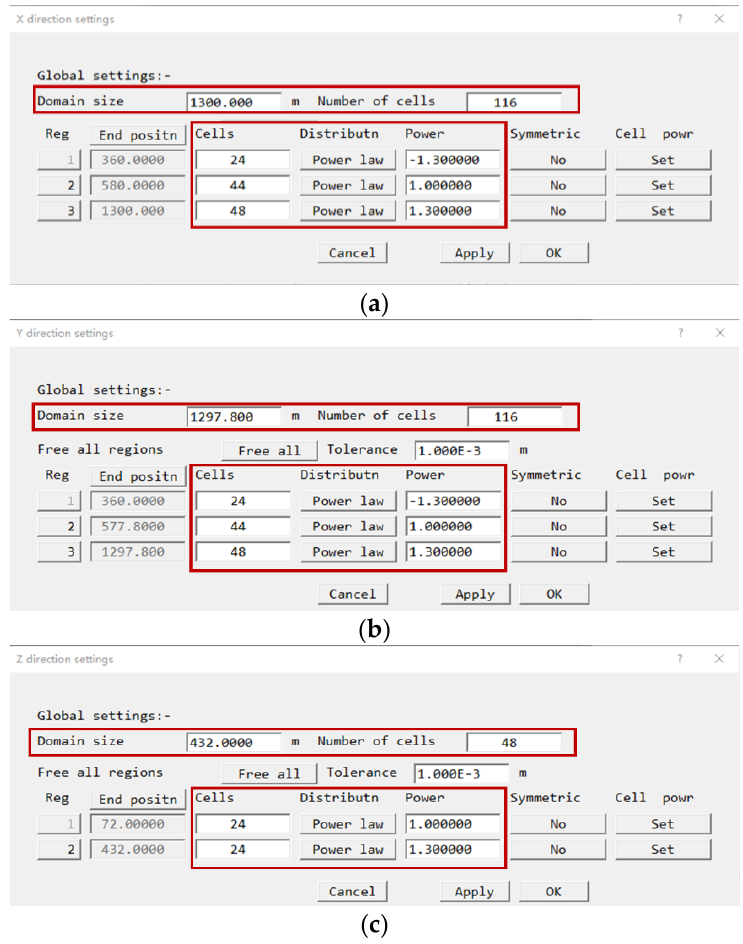
Figure A5. The XYZ direction grid settings ( a ) X axis, ( b ) Y axis, and ( c ) Z axis.